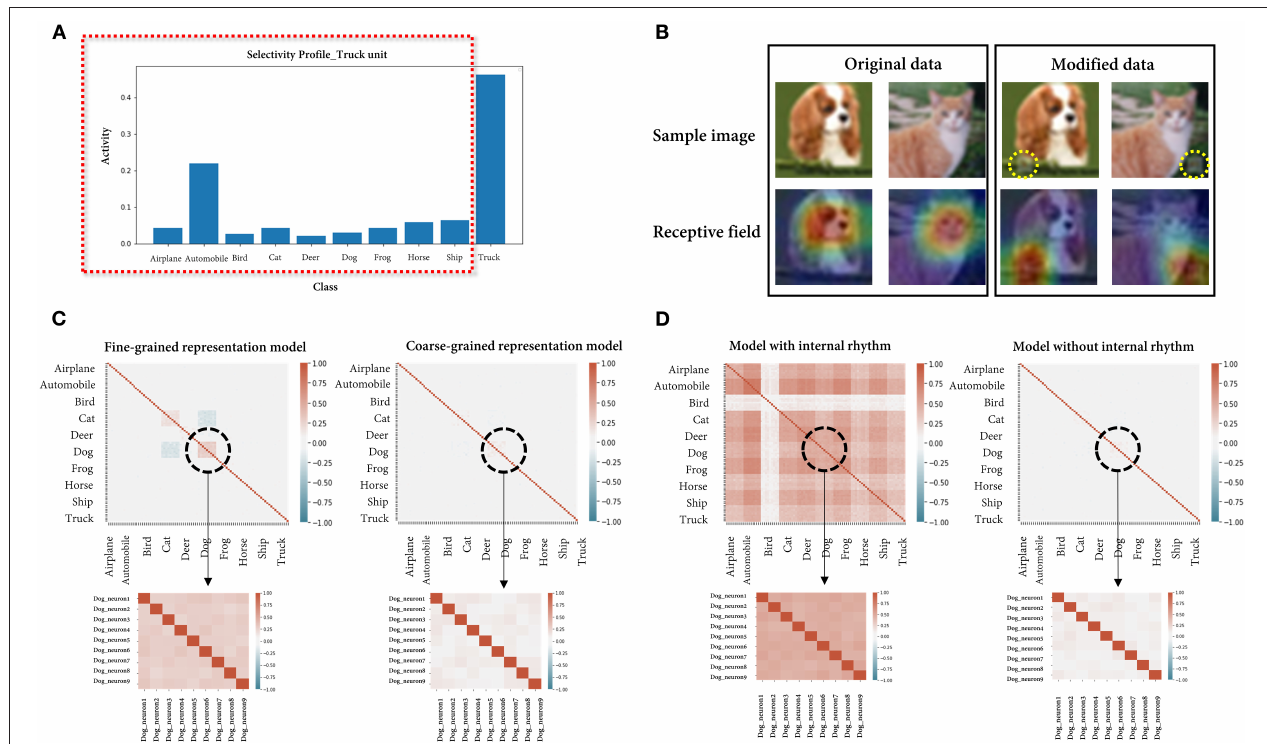
FIGURE 6 | Simulation results using a convolutional neural network. (A) The average activities of the truck unit for each stimulus feature are presented. As expected, the unit showed the highest mean activity for the optimal feature (truck), while it also showed considerable activity for a suboptimal feature (automobile). (B) Instance images (top) of a dog and cat in the original/modified (logo-synthesized) dataset and the visualized class activation maps (bottom) from the model trained on either the original or modified dataset. The accuracy of the model is 90 and 100% on each dataset, respectively. Note that what the latter model actually sees is the artificially synthesized logo, not the image label (expected feature). (C) Correlation matrices of individual neural activities randomly sampled from the model assumed to encode either the dog breed or the dog class (fine-grained/coarse-grained representation model). The enlarged parts are the values from the individual neurons within the dog unit. The averages of the correlations are 0.044 (fine-grained model)/0.038 (coarse-grained model) for the 90 total neurons and 0.360/0.199 for the 9 neurons within the dog unit. (D) Correlation matrices of individual neural activities randomly sampled from the model with/without a periodic internal rhythm. The averages of the correlations are 0.407 (model with internal rhythm)/0.038 (model without internal rhythm) for the 90 total neurons and 0.529/0.195 for the 9 neurons within the dog